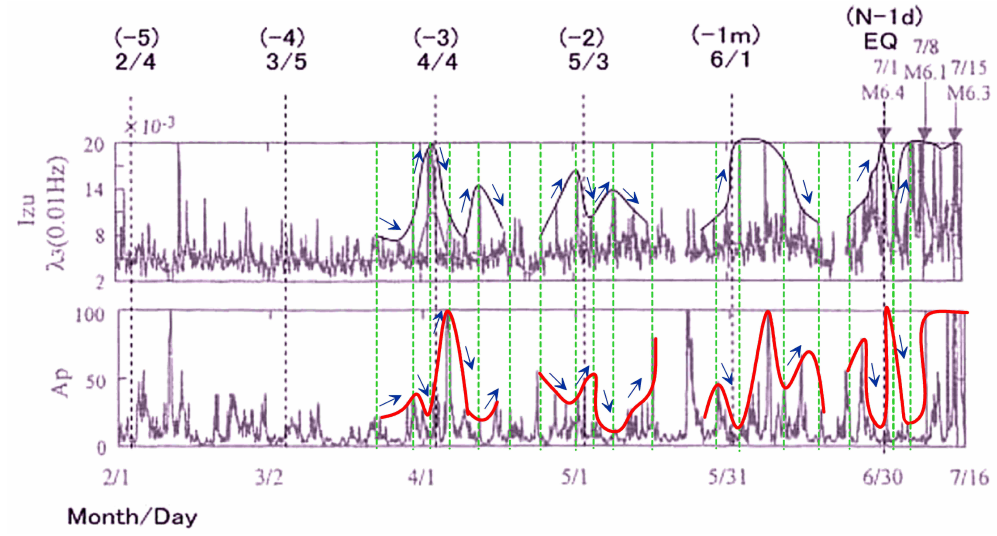
Fig. 1. Lunar phase analysis for the 2000 Izu swarm as reported by Hayakawa et al. (2011) (a reproduction of Hayakawa et al., 2011, Fig. 2). Upper panel: third PCA eigenvalue λ 3 of geomagnetic field component H at the frequency of 10mHz. Lower panel: Ap index time-series. In the upper panel the thick black line represents the envelope curve of λ 3 peaks as reported in the original figure, whereas in the lower panel the thick red line has been added onto the original view and refers to the envelope curve of Ap peaks. Blue arrows are also added to better highlight the inverse correspondence existing between the variations of the two envelope curves in the majority of the periods delimited by vertical dotted green lines. See text for